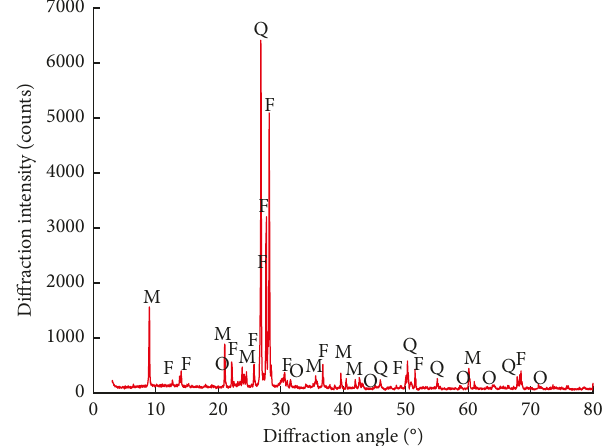
Figure 1: X-ray diffraction pattern of granite. M: mica; Q: quartz; F: feldspar; O: